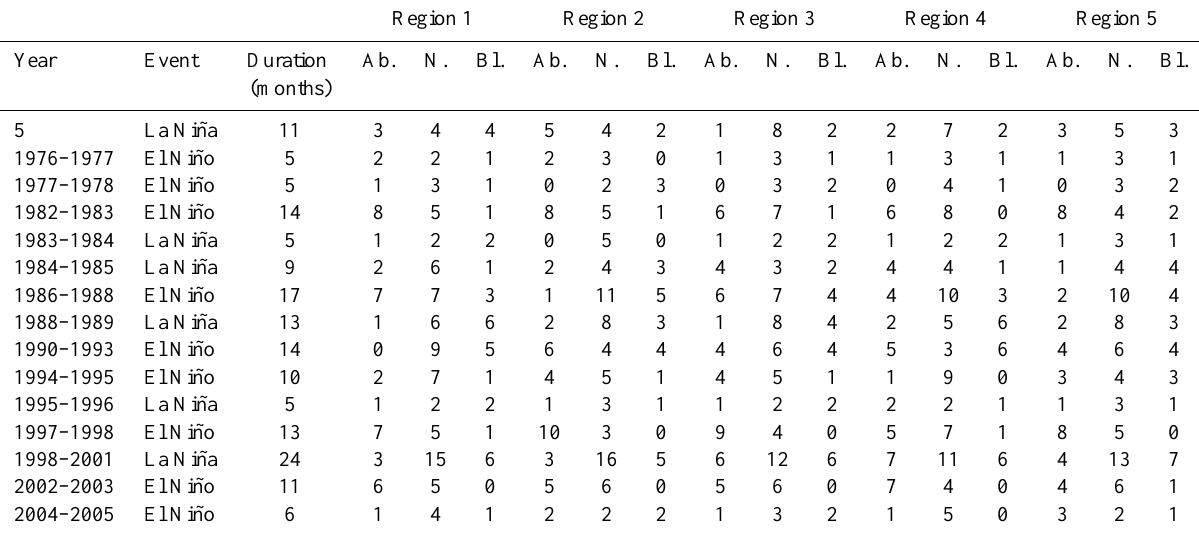
Table 2. ENSO events and their influences on the precipitation of homogeneous regions, and the amount of months that observed precipitation above normal (Ab.), within normal rainfall (N.), and below normal rainfall (Bl.)